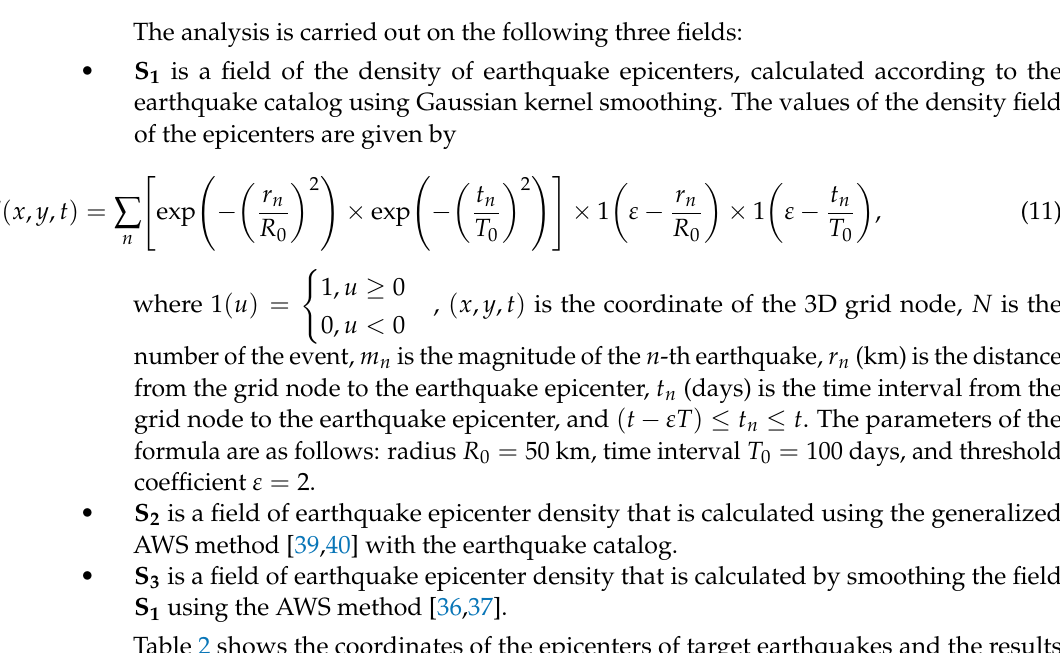
Figure 9. Analysis area and epicenters of test earthquakes in the interval 29 May 2010–20 May 2022 with magnitudes m ≥ 6.0 and depths of epicenters H ≤ 60